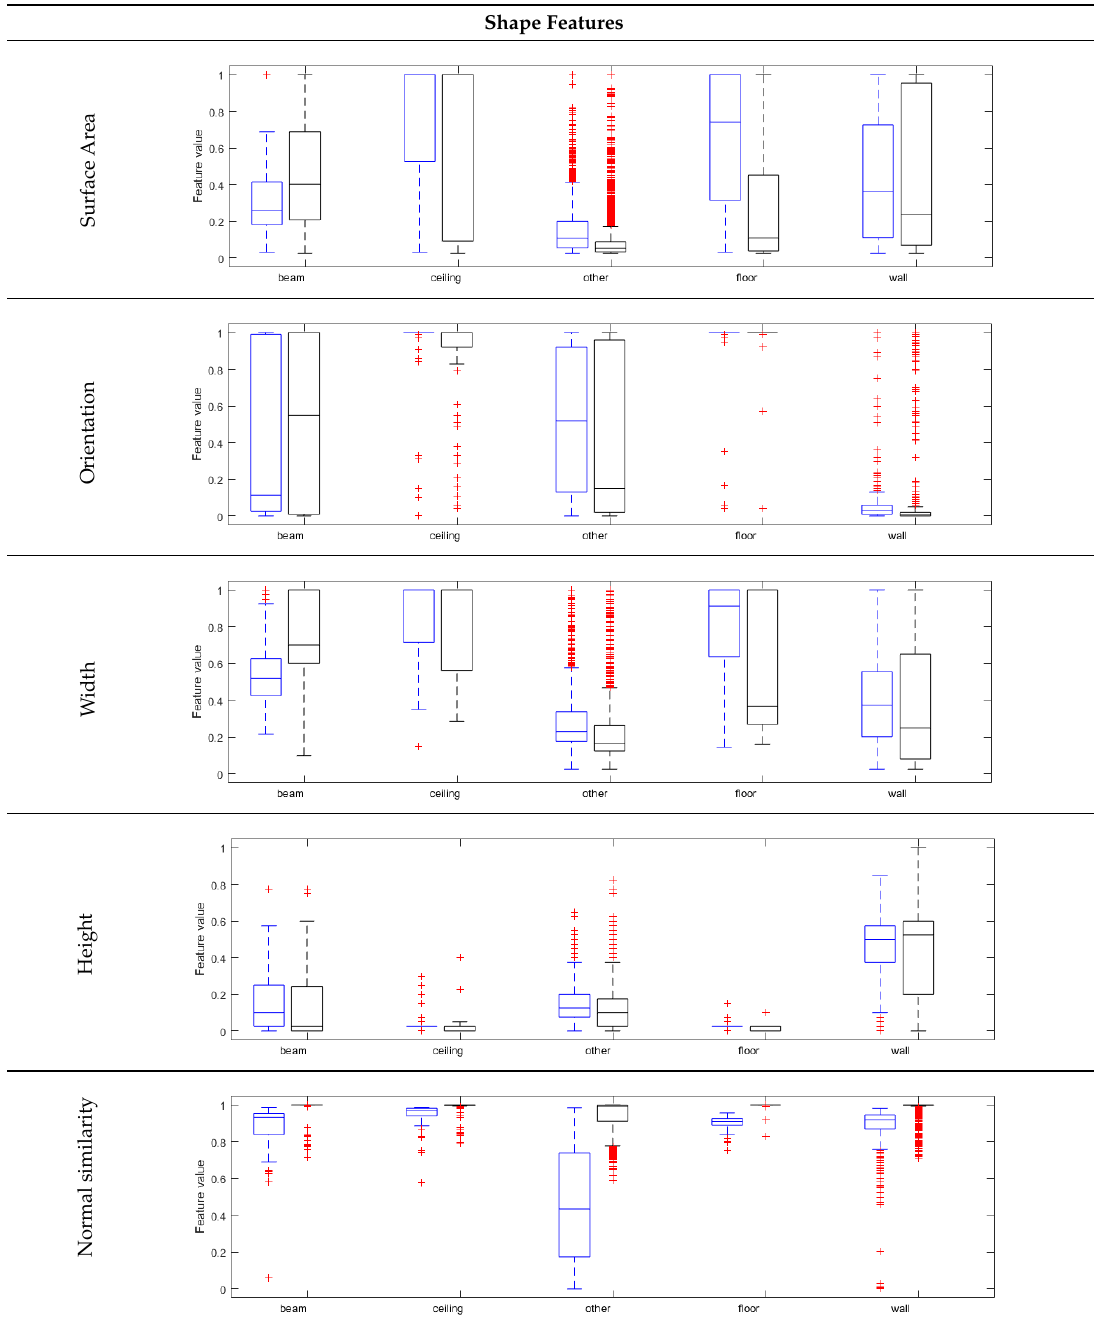
Table 6. Boxplot representation of the shape feature values produced by both methods for the different classes: (left) point-based classification and (right) the mesh-based